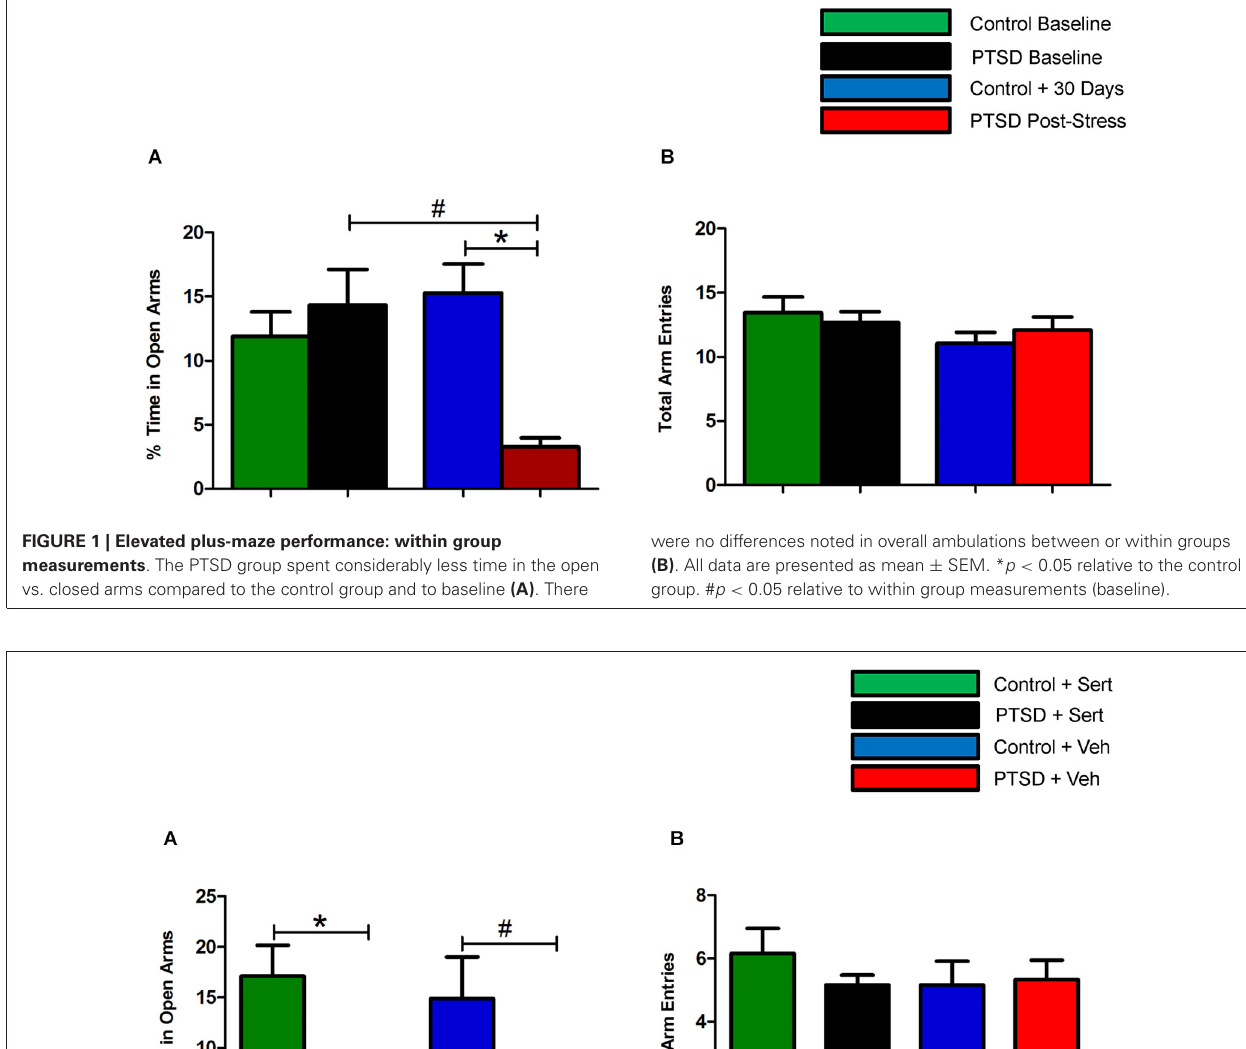
Veh group (A) . There were no differences in overall ambulations in any of the four groups after the treatment period (B) . All data are presented as mean ± SEM. * p < 0.05 between the treatment groups. # p < 0.05 between the vehicle groups.